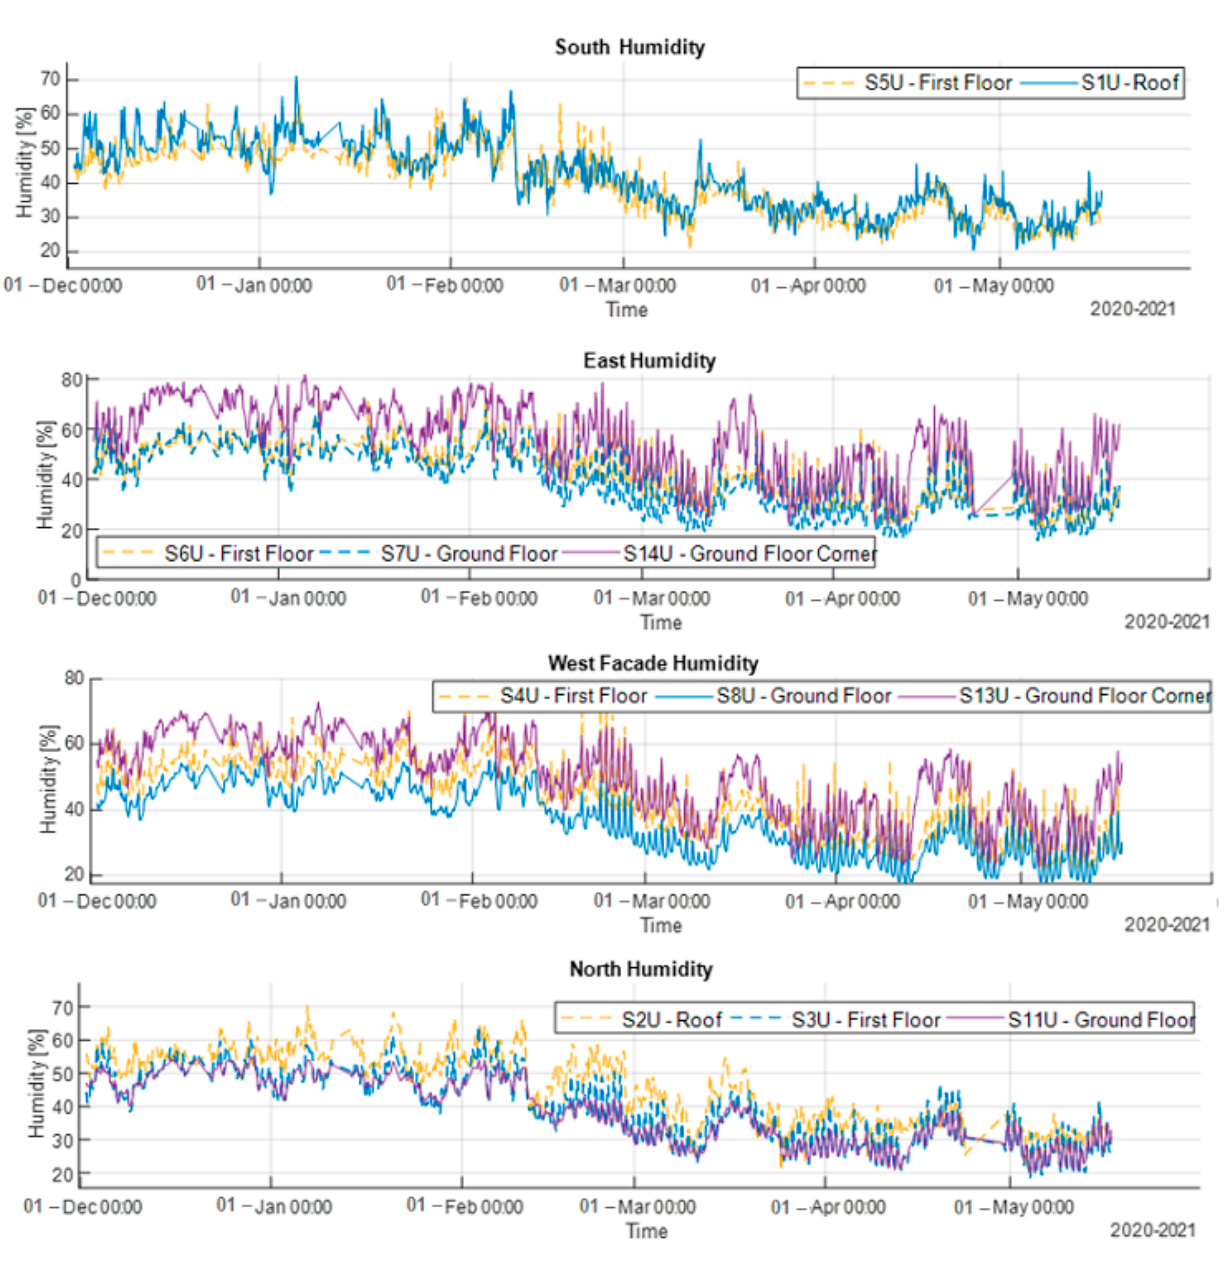
normal CO 2 concentration of air quality, which corresponds to category I according to EN Figure 17. Humidity data provided by the sensors from various locations of each façade. 15251.